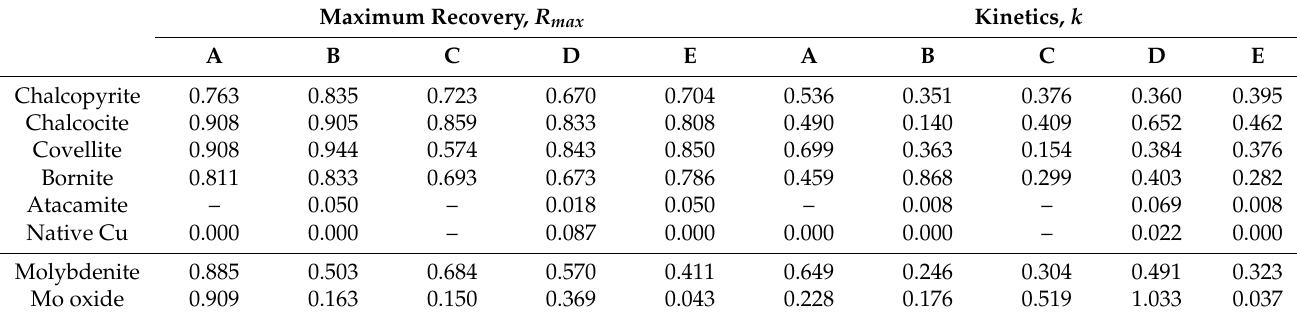
Table 8. Maximum recovery, R max , and kinetics, k, for each mineral with flotation in each ore sample. Maximum Recovery, R